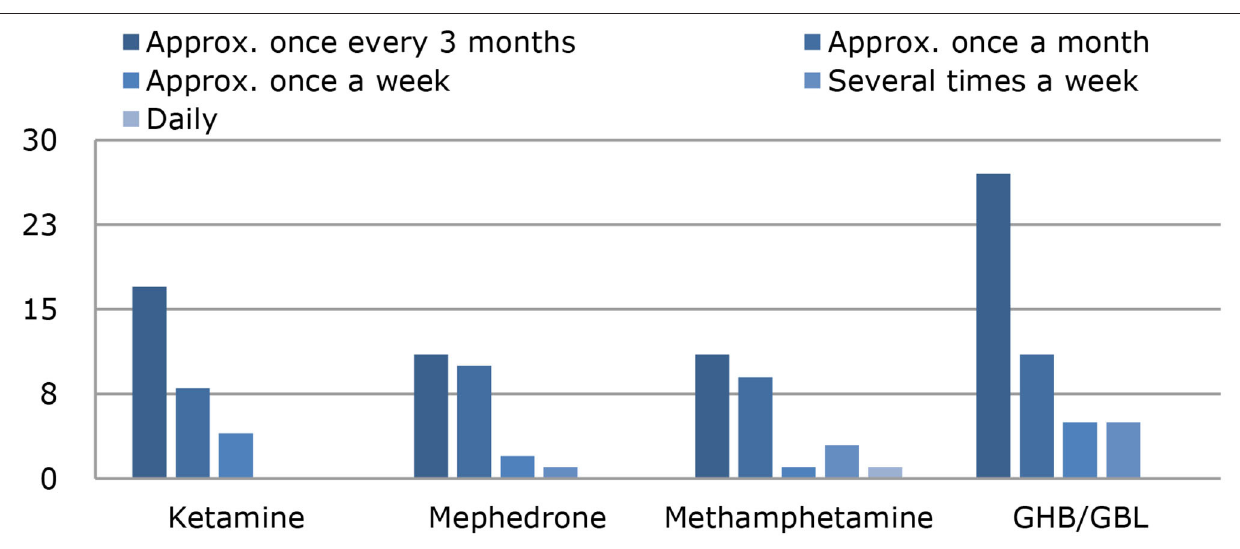
FIGURE 2 | Use of the 4 chems in the group of chemsex users ( n = 123) in the past 12